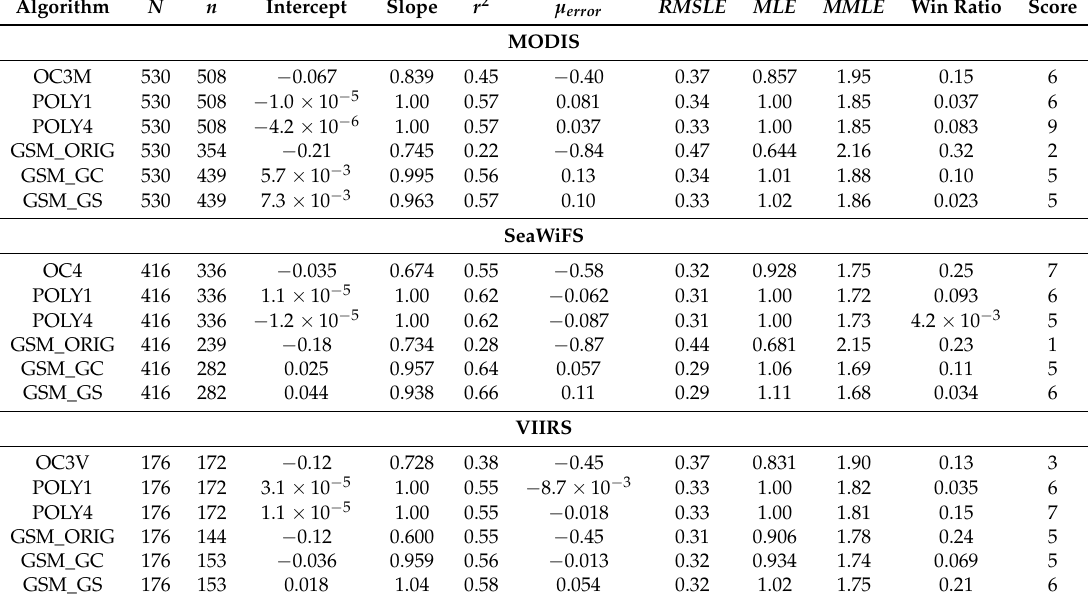
Table 3. Statistics computed for OCx, POLY1, POLY4, Garver–Siegel Maritorena